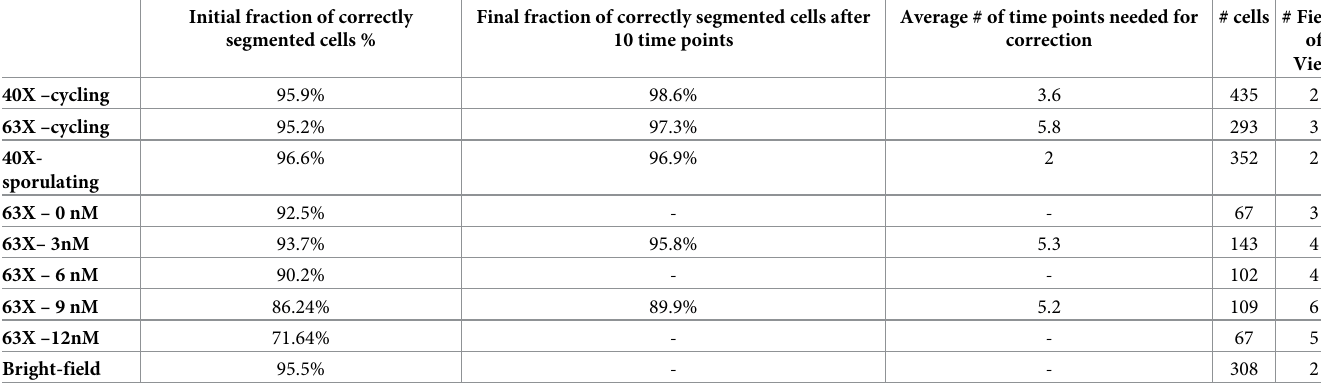
Table 1. Automated seeding performance. Initial fraction of correctly segmented cells